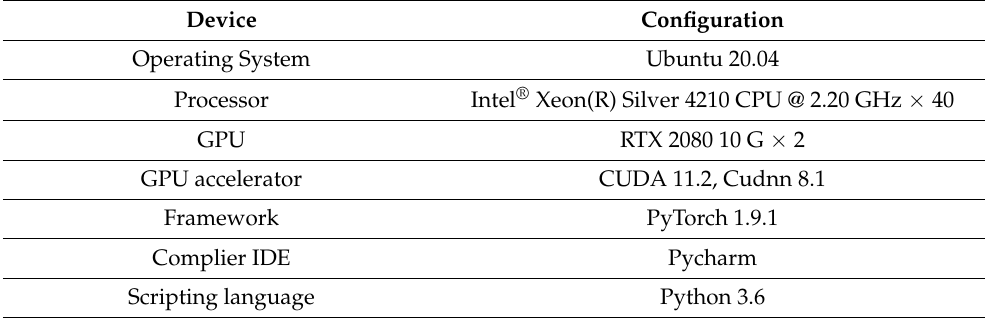
Table 3. Training/Testing setup environment on GPU